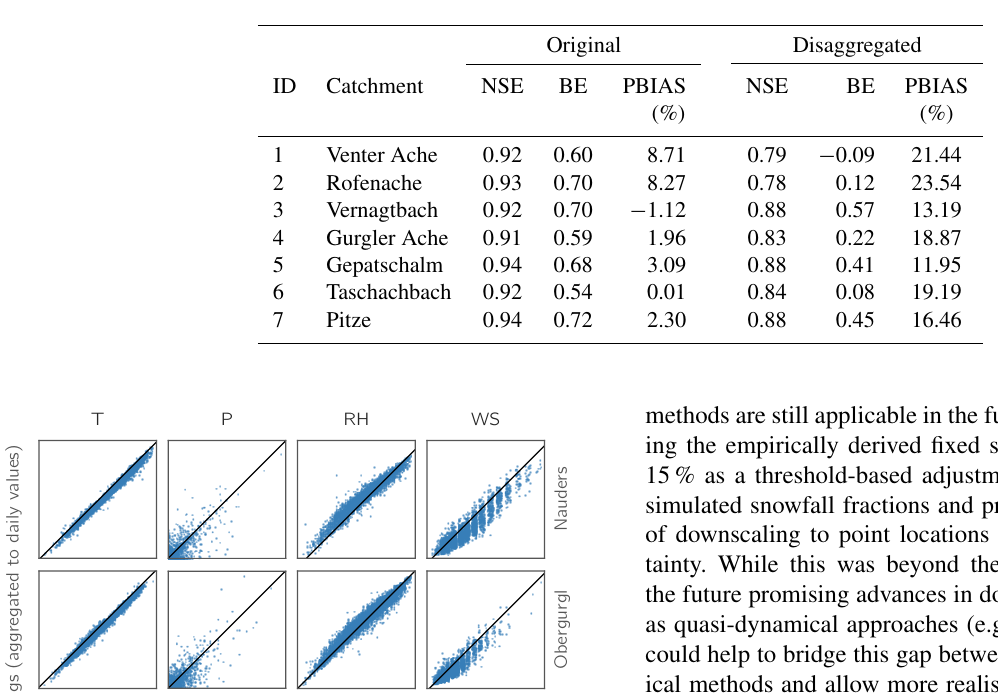
Table 3. NSE, BE, and PBIAS of observed vs. simulated runoff in the period 1998–2006 for the model runs using original hourly meteoro- logical data and disaggregated daily data, respectively.